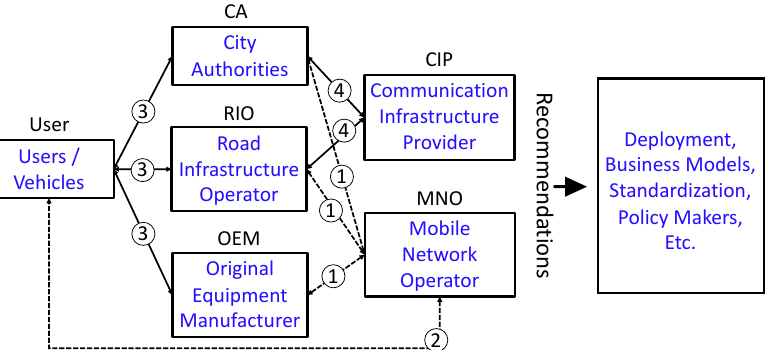
Figure 6. Inter-stakeholders relationship for L-5